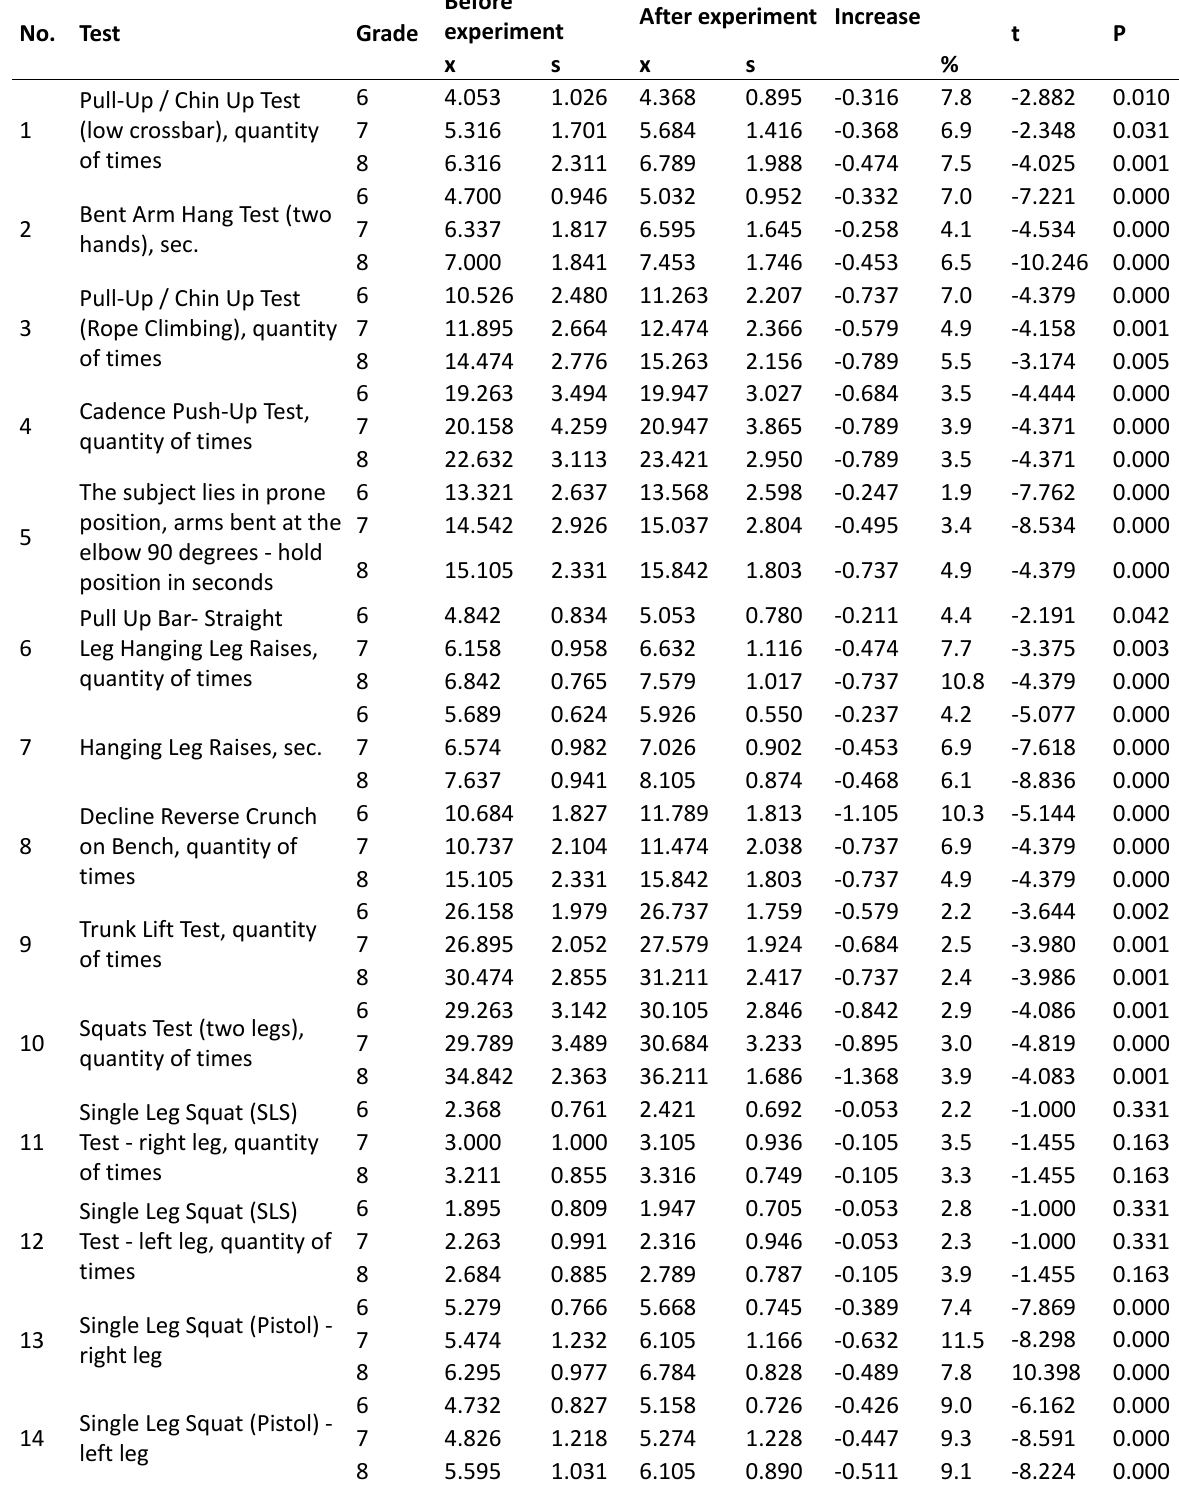
Table 2. Test results of strength fitness of 6 th -8 th grade boys (experimental group). Circuit training method